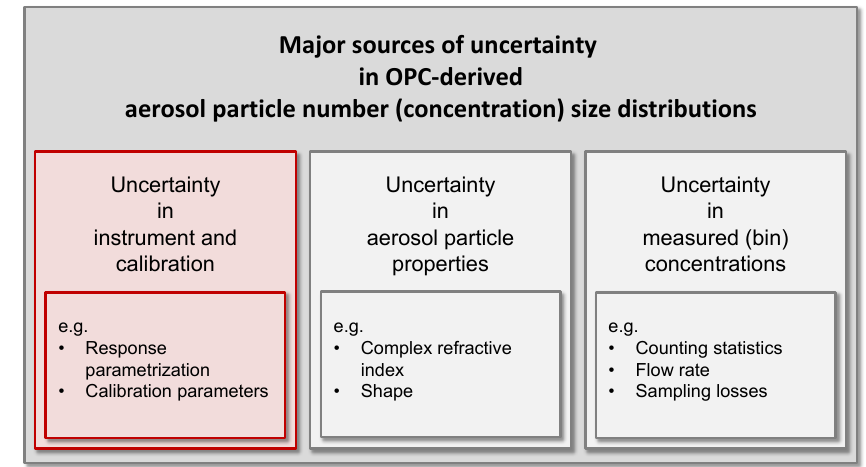
Figure 1. Sources of uncertainty for size distributions derived from OPC measurements. The main purpose of this study is to introduce an advanced description of OPC response and to offer improved estimates for the corresponding uncertainties (red-rimmed box).